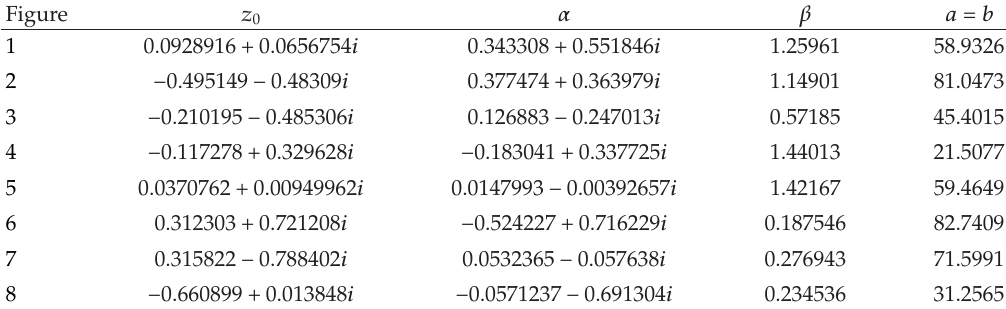
Table 1: Subordination of harmonic